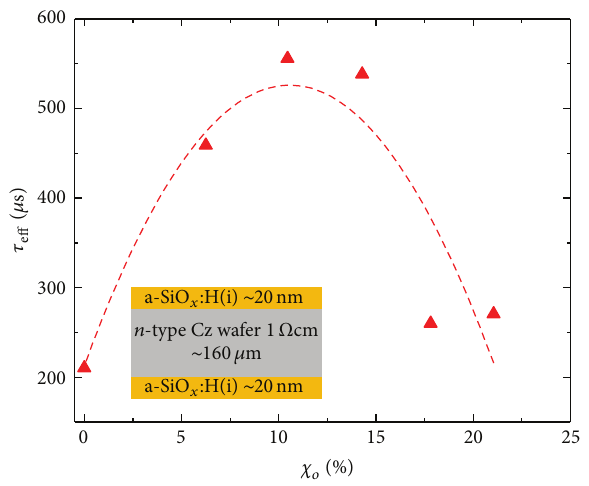
Figure 3: Lifetime as a function of CO 2 partial pressure while keeping other deposition conditions constant. The inset shows sample structure used in measuring lifetime. The line is a guide to the eye. A lifetime peak is observed at CO 2 partial pressure of 10%.